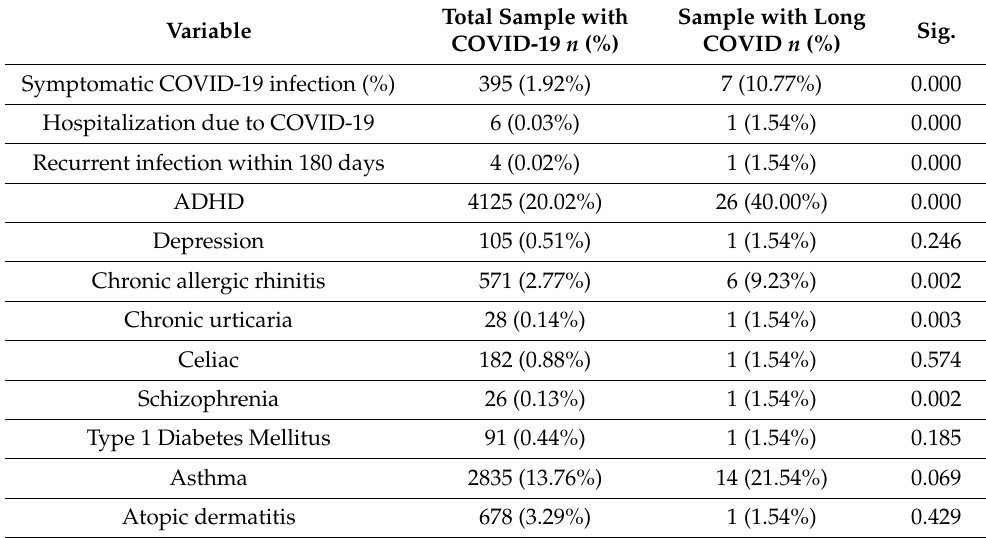
Table 2. Clinical characteristics of the study sample ( n = 20,601), analyzed by Chi 2 . Total Sample Variable